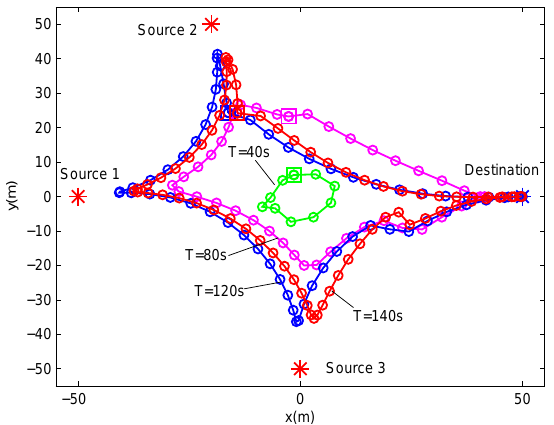
Figure 7. The trajectories of delay-tolerant case for different T under delay-tolerant case with θ = ( 0,0,0 ) .